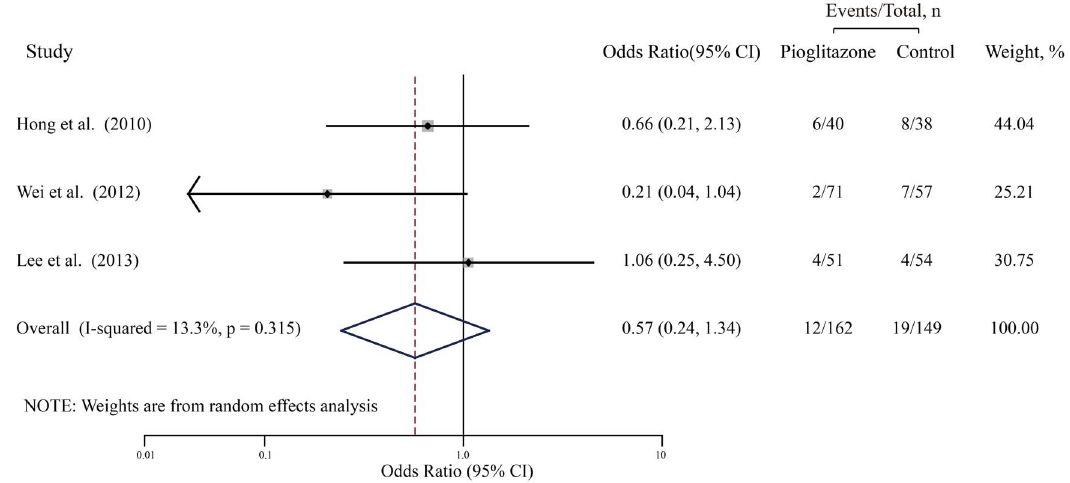
Figure 2. Meta-analysis of studies assessing effects of pioglitazone on the incidence of ISR. Black boxes indicate the odds ratios (ORs) with horizontal lines representing 95% CI (confidence interval). Hollow diamond plot indicates the overall pooled OR with 95% CI using random effects model. ISR, In-stent restenosis.